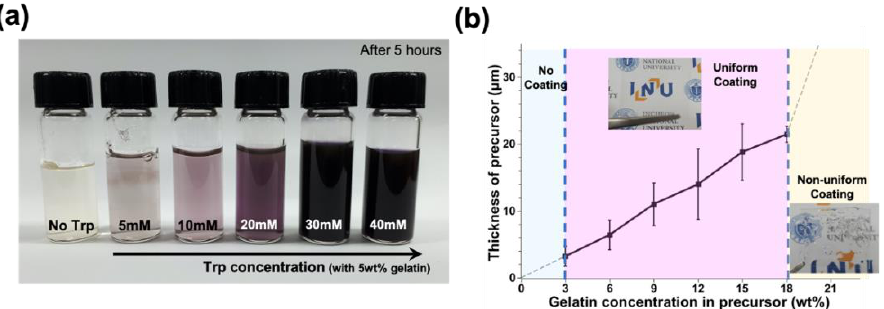
Figure 2. Optimal concentration of precursor composition. ( a ) Generation of nanoparticles by changing tryptophan (Trp) concentration from 0 mM to 40 mM, and ( b ) change in precursor coating thickness due to change in gelatin concentration from 3 wt% to 18 wt%.